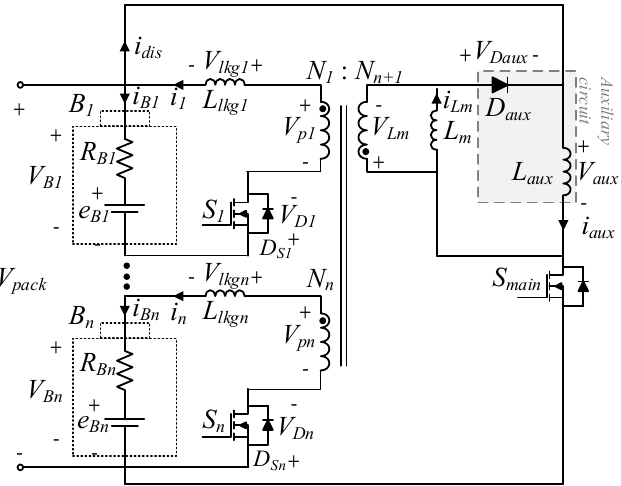
Figure 5. Proposed active voltage balancing circuit.